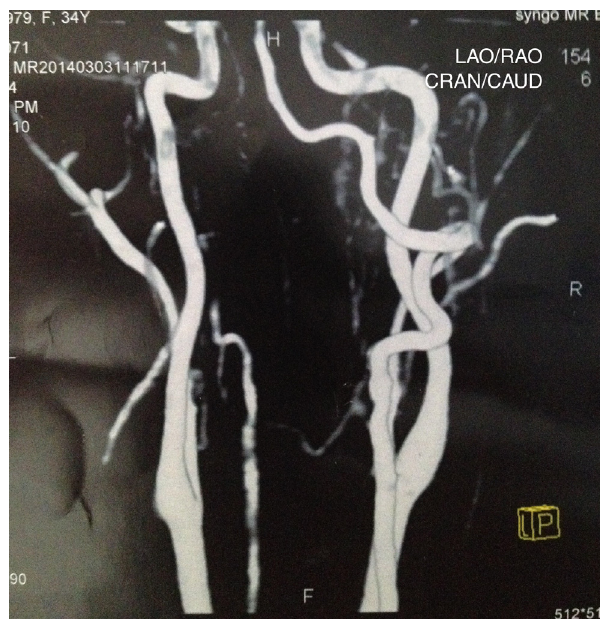
Angioresonance demonstrating a filling defect of left vertebral artery (posterior view).